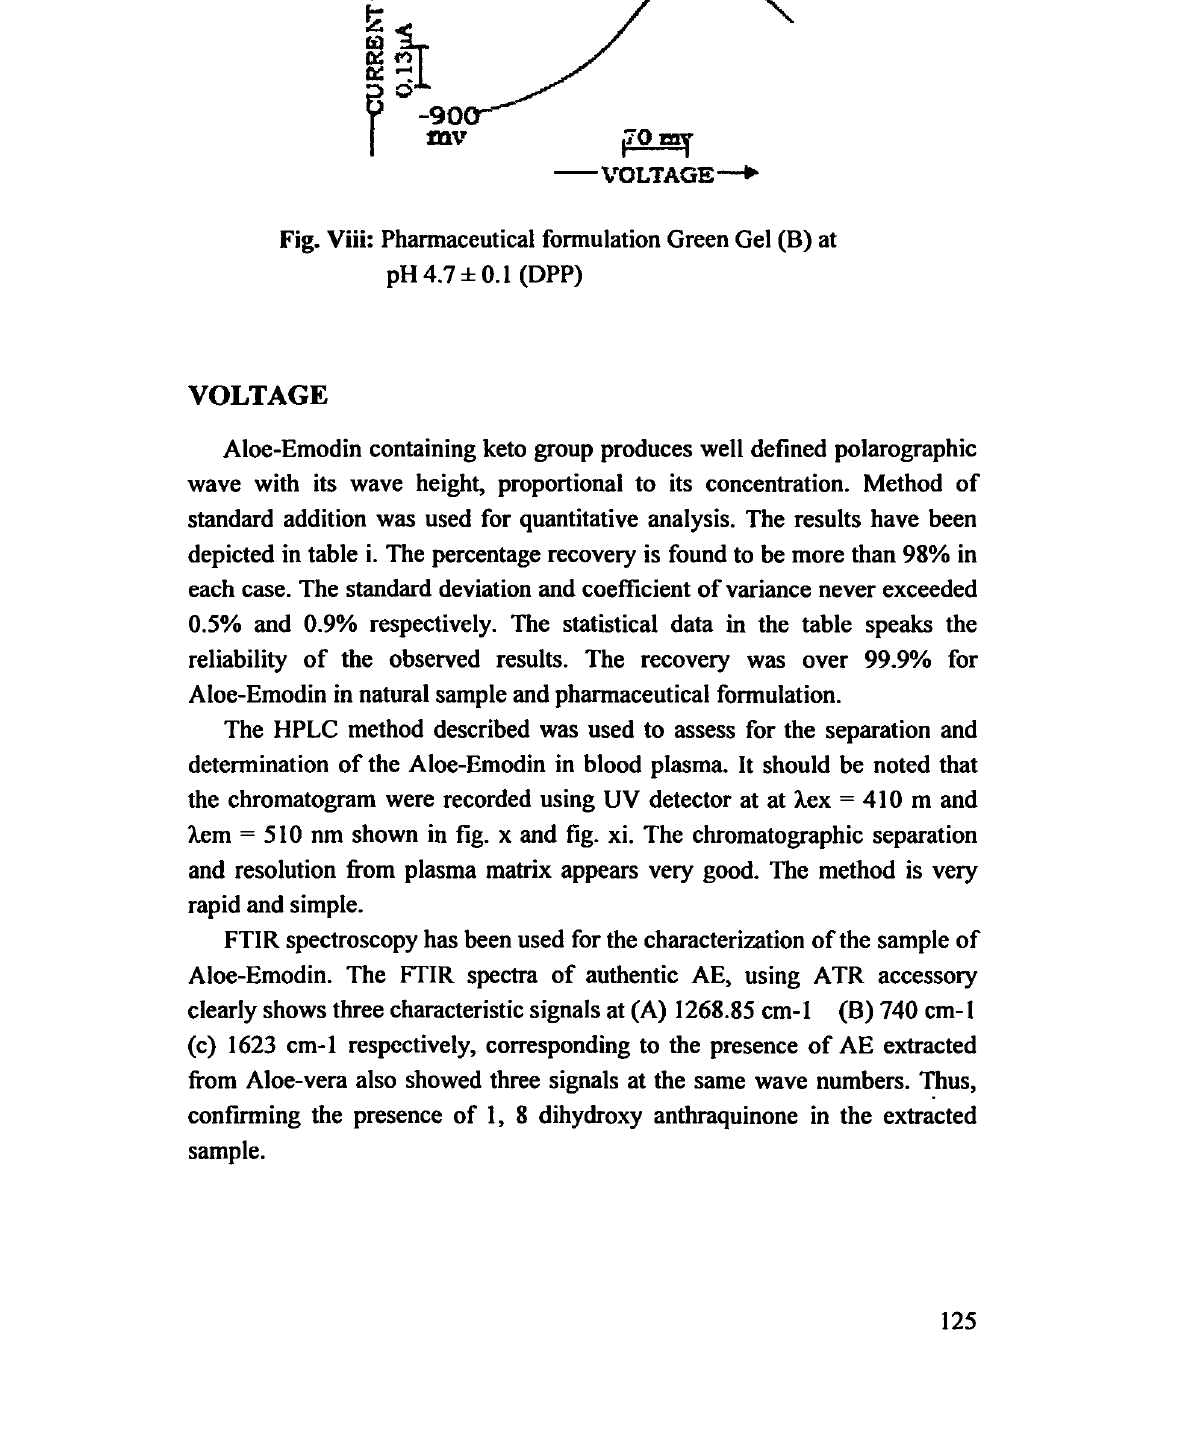
Fig. Viii: Pharmaceutical formulation Green Gel (B)